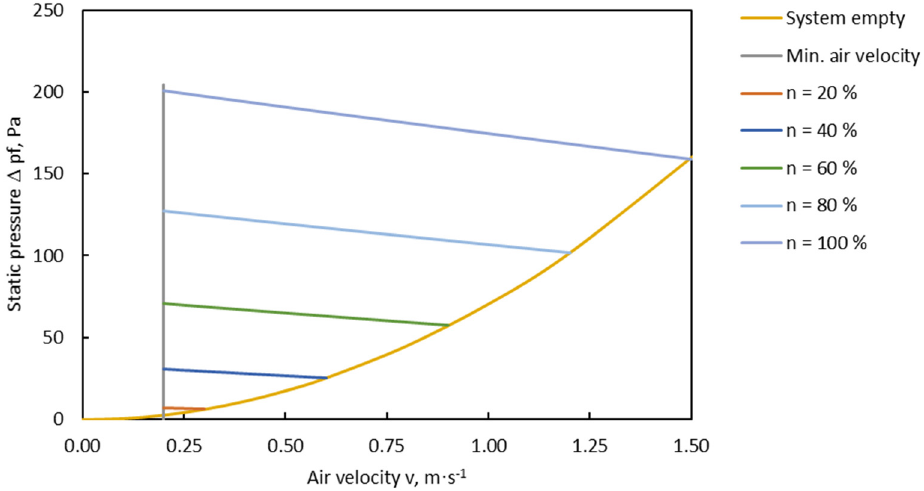
Figure 4. Static pressure Δ pf vs. air velocity v; characteristic curves of fan type 4412/2 HHP for different rotation speeds n in % of maximal rotation speed, and airflow resistance curve of empty system.